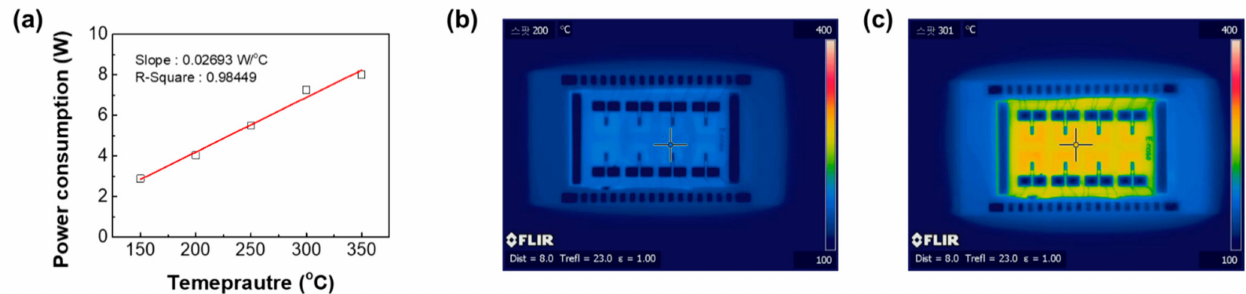
Figure 4. ( a ) Power consumption of the micro-heater. Infrared images of 2 × 4 sensor array with different operating temperature; ( b ) 200 ◦ C and ( c ) 300 ◦